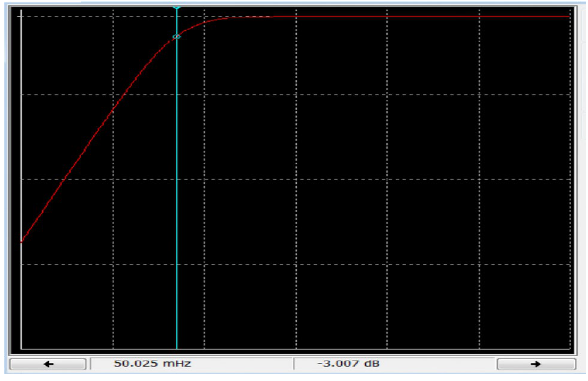
Fig. 15 Active 3rd order LPF bode plot illustrate cut-off frequency (160.063 m Hz ≅ 160 Hz)